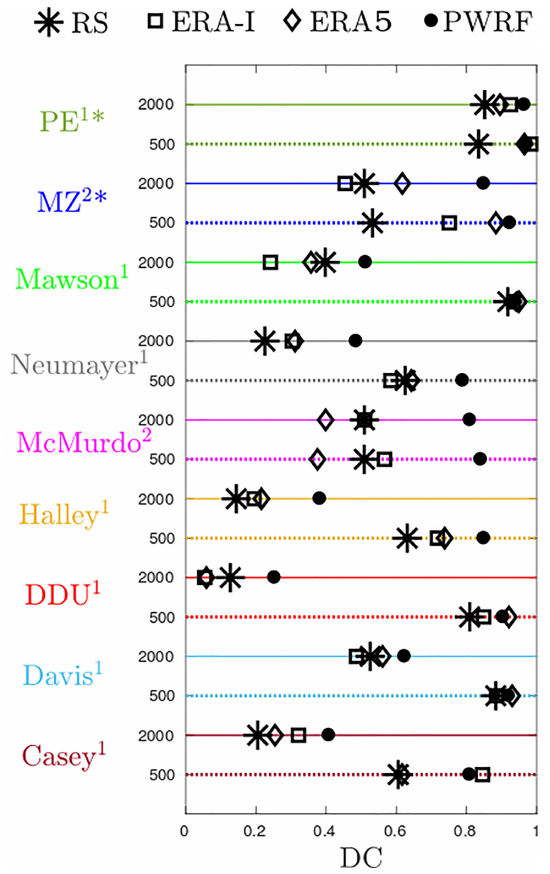
Figure 6. Yearly directional constancy at z = 500m (dotted axes) and z = 2000m (solid axes) at nine Antarctic stations. Polar WRF (PWRF), ERA-I and ERA5 data are conditioned to radiosounding (RS) times. Numbers in exponential form next to station names in- dicate the number of radiosoundings per day at the corresponding station. The “ ∗ ” symbol labels the two stations for which only data from December to February are